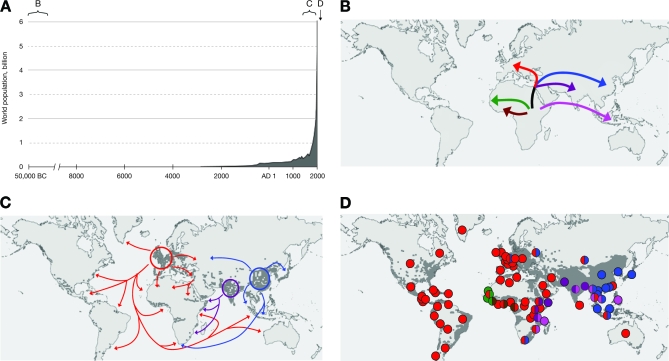
Out-Of-And-Back-To-Africa Scenario for the Evolutionary History of Human-Adapted MTBC(A) Global human population size during the last 50,000 y. The letters above the graph indicate the time periods corresponding to (B), (C), and (D), respectively (data source: http://en.wikipedia.org/wiki/Image:Population_curve.svg). (B) Hypothesized migration out of Africa of ancient lineages of MTBC. Colored arrows correspond to the six main human-adapted MTBC lineages shown in Figure 1. The hypothesized common ancestor of the three modern lineages (in red, purple, and blue) is indicated in black.(C) Recent increase of global human population. Each dark grey dot corresponds to 1 million people (data source: http://www.pbs.org/wgbh/nova/worldbalance/numb-nf.html). The population increase was strongest in Western Europe, India, and East Asia (Figure S3). These three geographic regions are each associated with one of the three modern MTBC lineages (red, purple, and blue). Recent human migration, trade, and conquest have promoted global spread of these modern MTBC lineages.(D) The human population has reached 6 billion. The distribution of the six main human-adapted MTBC lineages we observe today is shown (colors correspond to Figures 1 and S2; based on data from [19,21]).